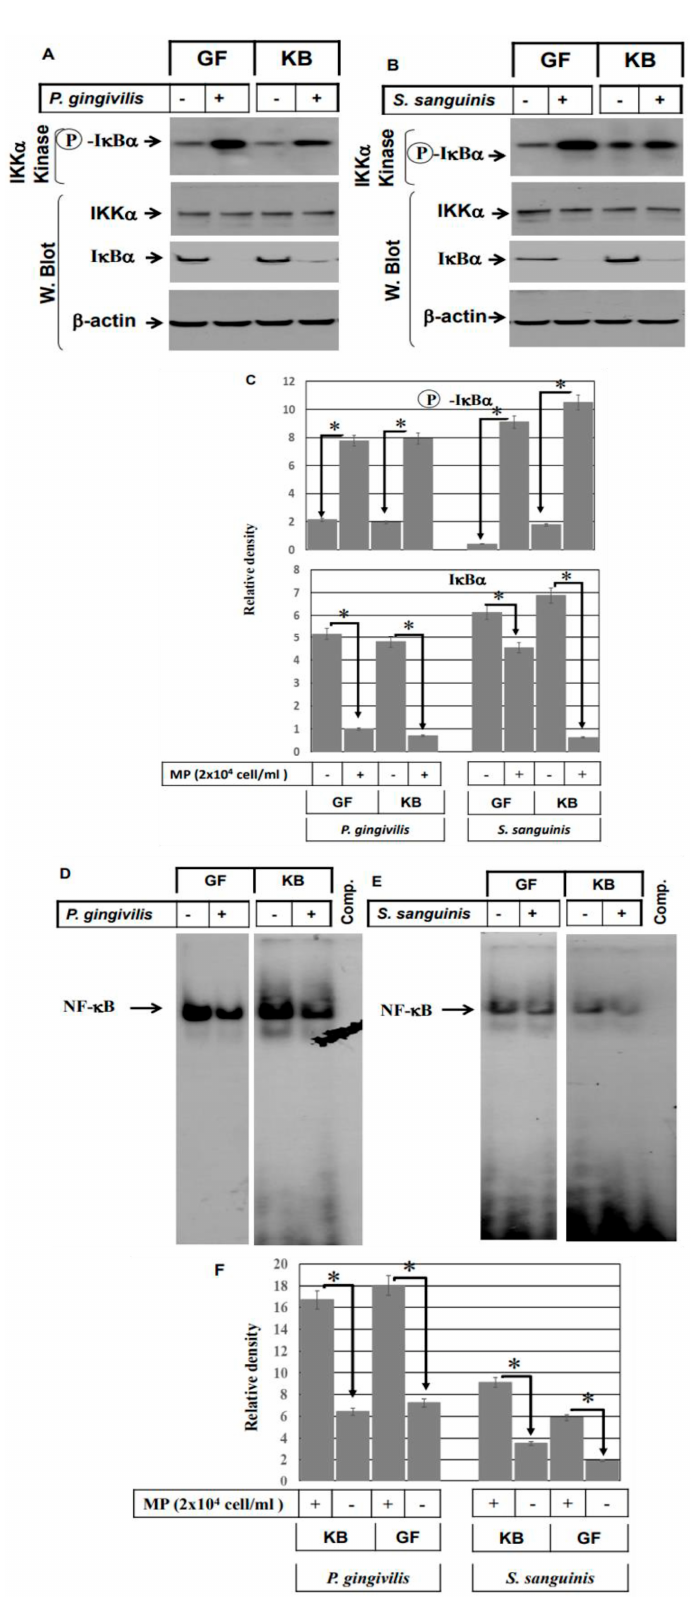
2 Figure 5. Induction of NF- κ B pathway by both gram − and gram + bacterial pathogens in oral mucosa-derived cells. Both GF and KB cells were stimulated with either heat-inactivated P. gingivalis (2 × 10 4 cells/mL) or heat-inactivated S. sanguinis (2 × 10 4 cells/mL) microbial pathogens (MPs)